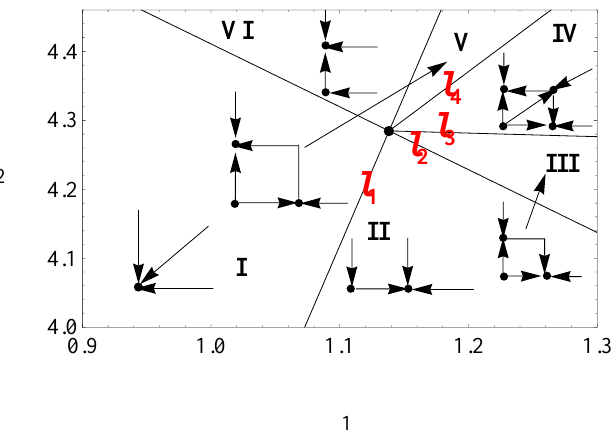
Figure 2. Bifurcation sets on τ 1 versus τ 2 and dynamics near Hopf–Hopf interaction point of inertial models (17). The black intersection dotted point is the bifurcation point (1.1383,4.2847) in the portrait. The delayed plane is divided into six regions by the red line l i ( i = 1,2,3,4 ) . ( I ) A stable equilibrium; ( II ) and ( III ) periodic motion with low frequency; ( IV ) coexistence of periodic oscillations; ( V ) and ( VI ) periodic motion with high frequency. ( τ ) ∈ region (I), the trivial equilibrium of Equation (17) is asymptotically stable. In addition, Equation (17) undergoes a Hopf bifurcation at the line l 1 . Region (I) is a stability zone.